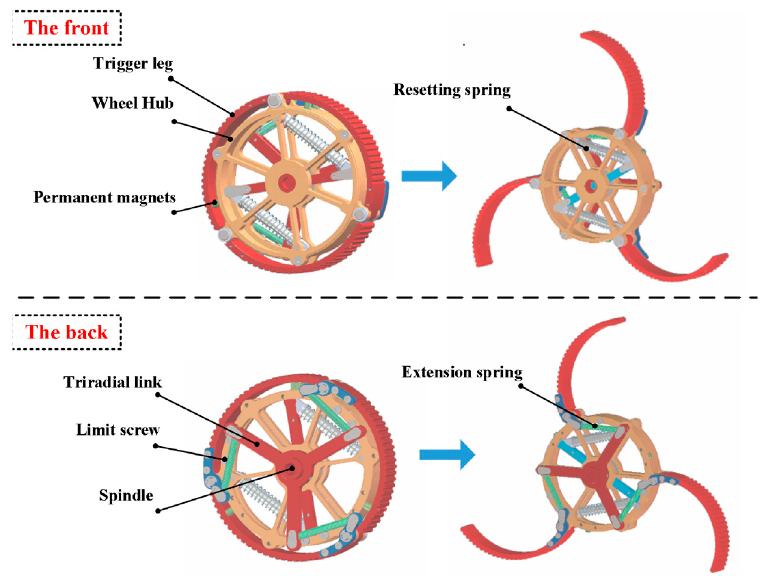
Figure 3. Structure of transformable wheel.